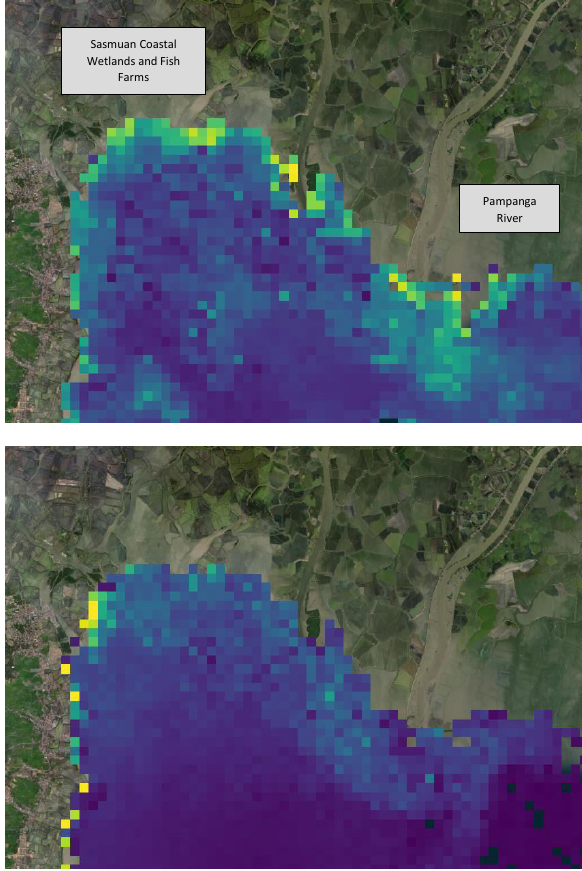
Figure 7. High CDOM Areas near Pampanga River, Sasmuan Pampanga Coastal Wetlands and Fish farms (Top: May 19, Bottom: June 18)